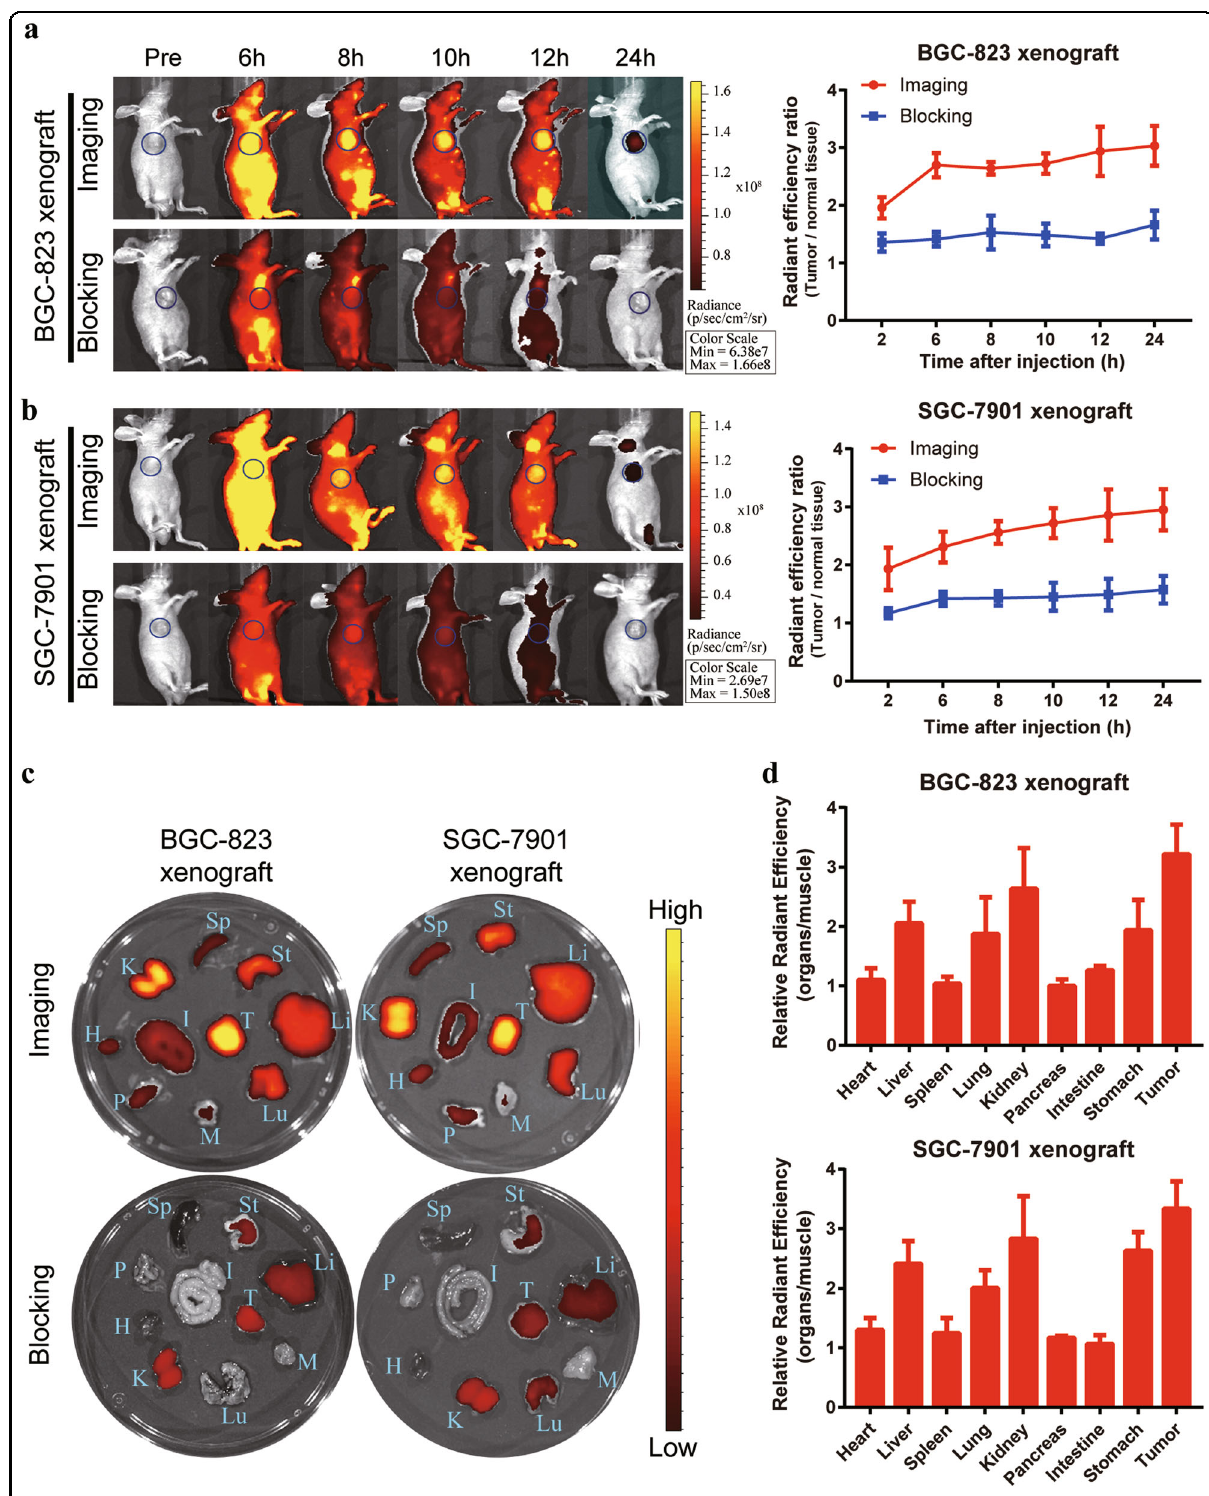
Fig. 3 In vivo FMI of GC tumors using IRDye800CW-SAHA. a Speci fi c in vivo fl uorescence signals were continuously observed in mice harboring BGC-823 tumors after tail vein injection of IRDye800CW-SAHA. The signal-to-background ratios were calculated (right). b Similar results were observed in the SGC-7901 xenograft model. c Ex vivo FMI of tumors and major organs was performed after in vivo observation. A high fl uorescence signal was observed in the tumors. d Statistical analysis of the biodistribution and fl uorescence intensity of SAHA in major organs of the imaging group mice. T, tumor; Lu, lung; St, stomach; H, heart; Li, liver; Sp, spleen; K, kidney; I, intestine; P, pancreas; M,